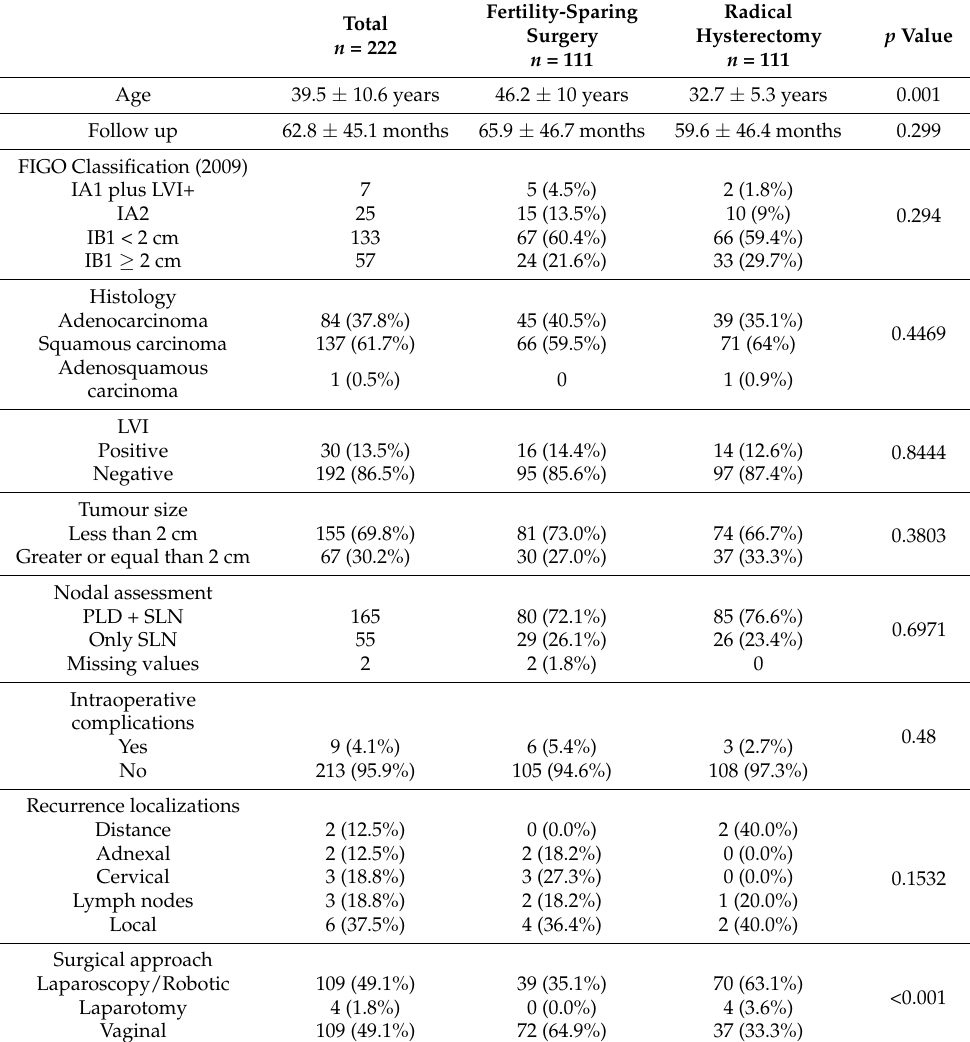
Table 1. Clinicopathological characteristics of the unmatched